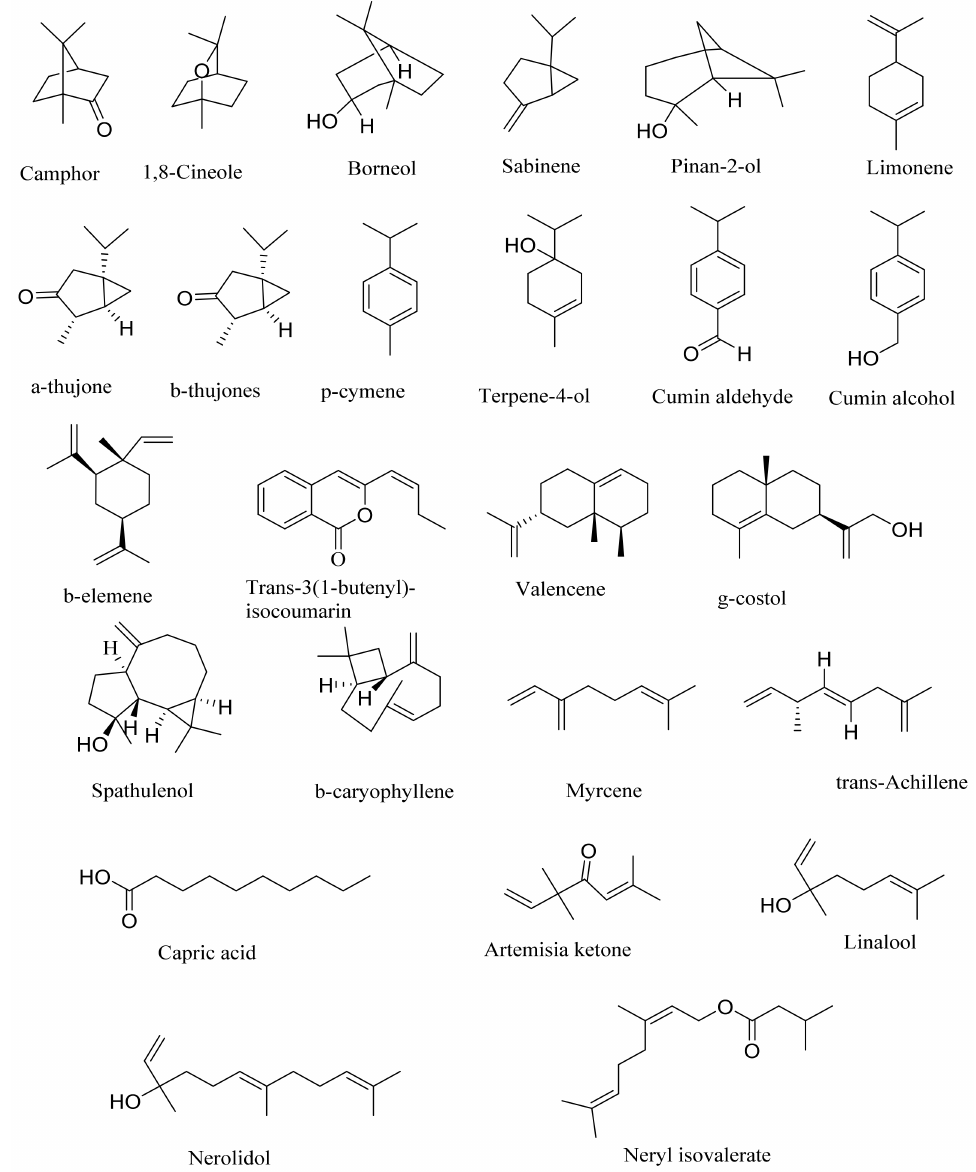
Figure 3. Structures of major components in essential oils from Artemisia L. The research data indicates that the essential oil from the Artemisia genus of Kazakhstan has antibacterial, antifungal and antiviral activities. The study of the antimicrobial activity of the essential oil from A. sieversiana showed that it was active toward gram-negative strains and yeasts [69]. The determination of the major components of essential oils from Artemisia species growing in Kazakhstan showed that 1,8-cineole, α -thujone, β -thujone and camphor were present in higher amounts among most of the plant species (Table